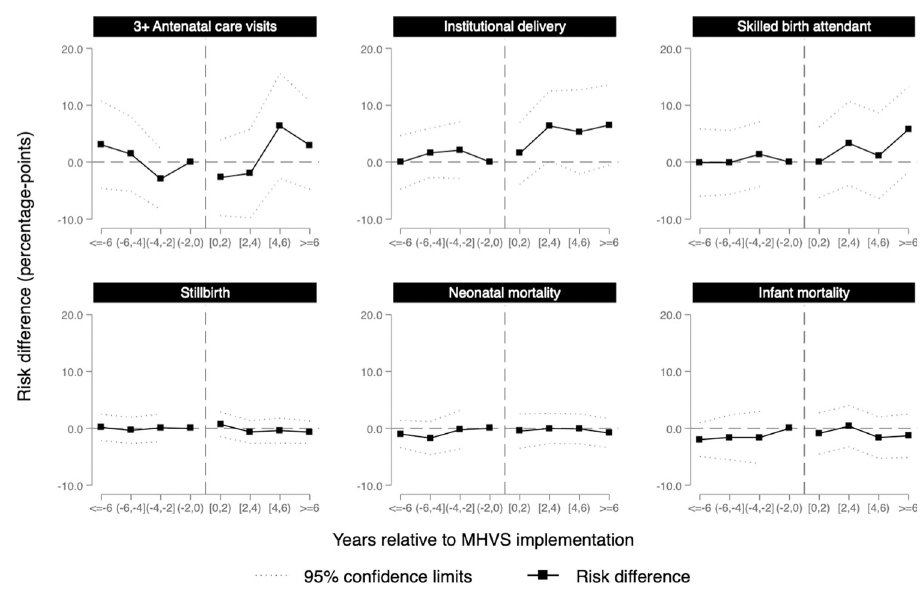
Fig 3. Weighted event study estimates of the effect of gaining access to the MHVS in specified periods before and after the implementation of the program; BDHS data, 2000–2016. Notes : Models included fixed effects for 6 divisions, fixed effects for year of birth (or the pregnancy outcome in analyses of stillbirth), and a vector of time- varying individual-level covariates, including household size, maternal age at marriage, women’s age at the time of the stillbirth or live birth, rural residence, women’s and husband’s educational attainment, household wealth (above or below median), whether the interval between the index pregnancy or birth outcome and a prior birth was short ( < 24 months) or not (24+ months and first births), and prior stillbirth (in analyses of stillbirth). Weights accounted for the following upazila-level characteristics described in S2 Table : age structure, rural population, literacy, educational attainment, school attendance, poverty, employment, and household characteristics. Event periods included 4 leads (i.e., 6+, 4–6, 2–4, and 0–2 years prior to the introduction of the MHVS) and 4 lags (i.e., 0–2, 2–4, 4–6, and 6+ years after the introduction of the MHVS), with the 2-year period prior to implementation taken as the reference. Each coefficient represents the difference in the probability of the outcome (percentage point differences) comparing treated and control observations in the event period relative to the reference period; 95% confidence intervals account for the clustering of observations within upazilas. Sample sizes are reported in S1 Table , and the estimation of weights is described in Appendix B in S1 Appendix . BDHS, Bangladesh Demographic and Health Survey; MHVS, Maternal Health Voucher